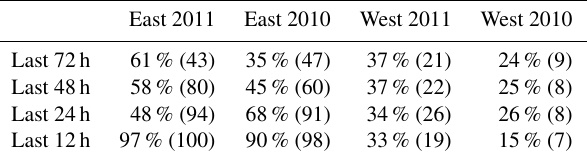
Table 3. Relative proportion of low-altitude (<300m) air masses passing over sea-ice-covered regions with respect to the total num- ber of low-altitude air masses along all back trajectories derived from the HYSPLIT model for 55 flight tracks from both campaigns (see text for details). In parentheses, the same percentages but for the 24 flights only. Relative proportions are indicated for both years and both sides of the peninsula, with the side referring to the (start) ending point of the air mass (back) trajectory. Percentages are com- puted over different time ranges, prior to reaching a given point of a flight track on either side. A region is considered as covered by sea ice as long as the sea ice concentration from the NIMBUS-7 SMMR is larger than 1% (see Sect. 4.1 for reference).